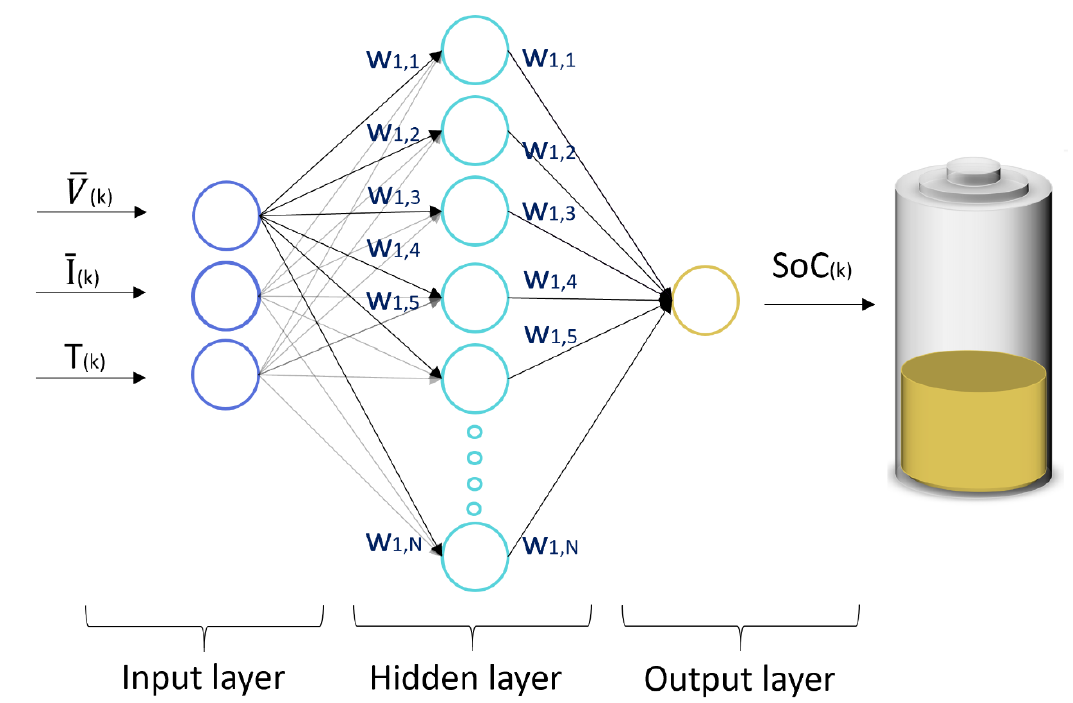
Figure 5. Architecture of a generalized feedforward neural network of voltage (V), current (I), and time (T) inputs, a double layer and nodes where W is the weights, and the state-of-charge (SoC) output.